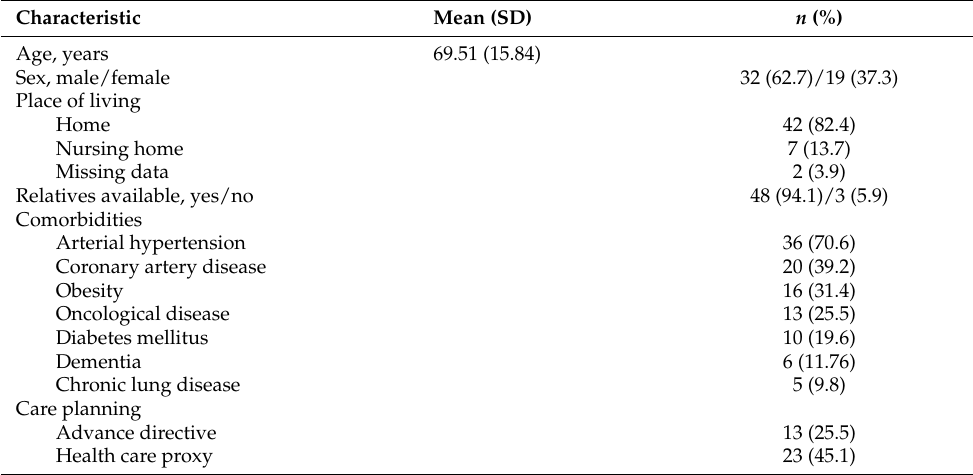
Table 1. Baseline patient